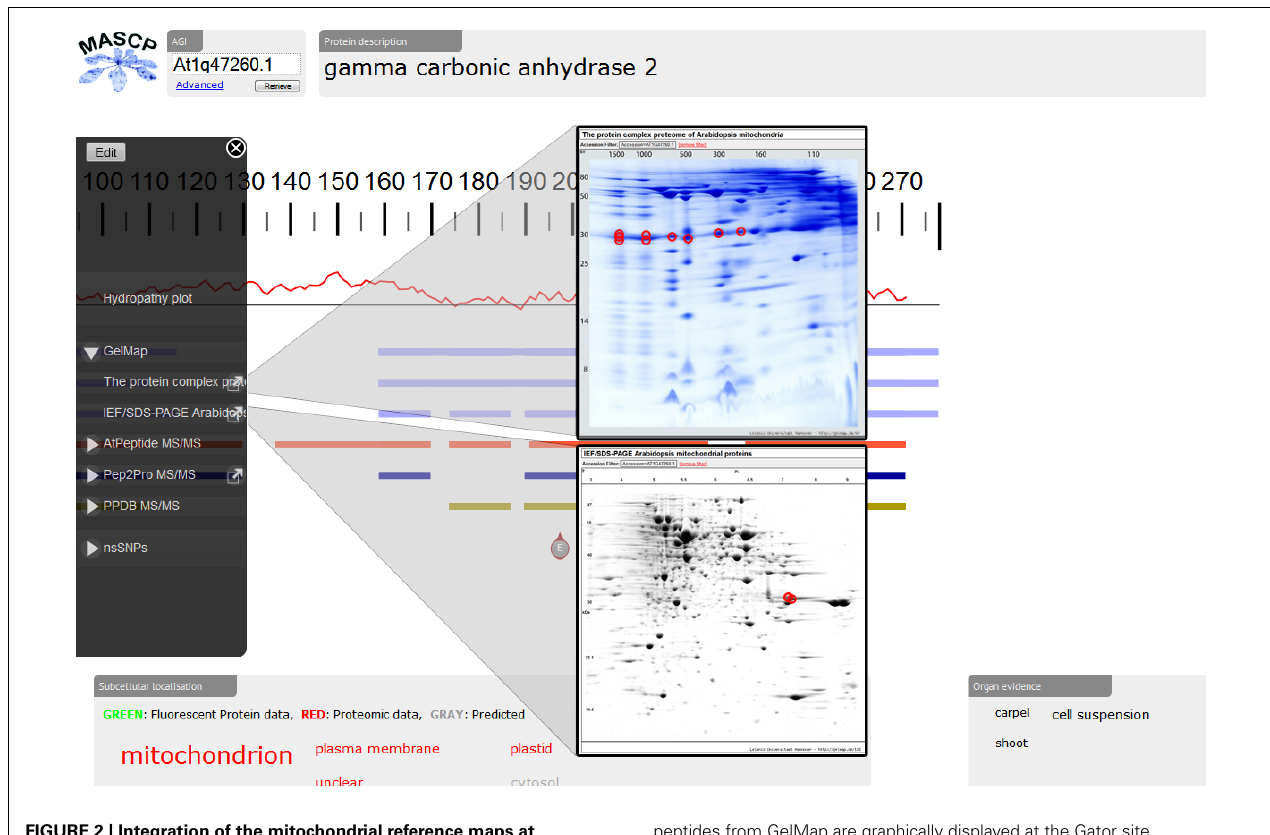
FIGURE 2 | Integration of the mitochondrial reference maps at GelMap into MASCP Gator (http://gator.masc-proteomics.org/). Upon submission of a protein accession (here: At2g47260), matching